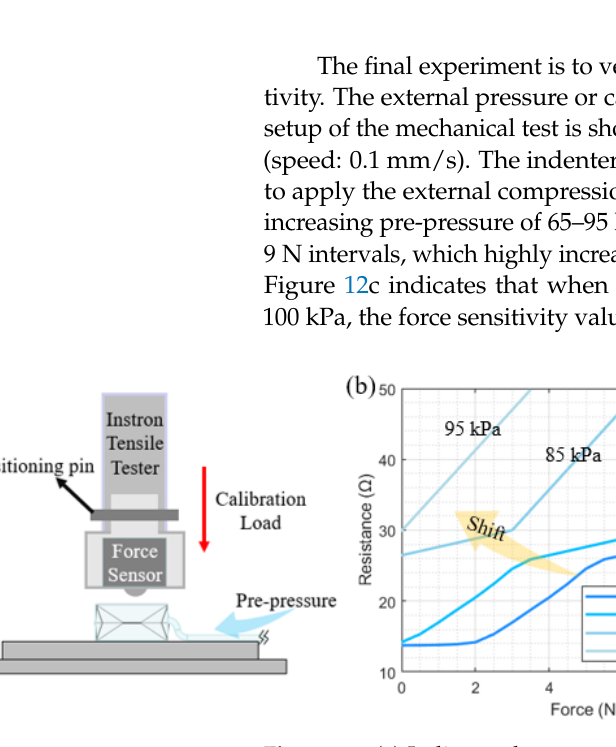
Figure 12. ( a ) Indicates the setup of the calibration experiment, and the force sensor is fixed into the suitable clamps (fabricated by 3D printing) to identify the load value; ( b ) represents the offset relationship curves between the microfiber sensor’s resistance and adding force when the pre-pressure is at the approximate linear range (65–95 kPa); ( c ) represents the relationship curves between the microfiber sensor’s resistance and adding force when the pre-pressure is at the exponential zone (100